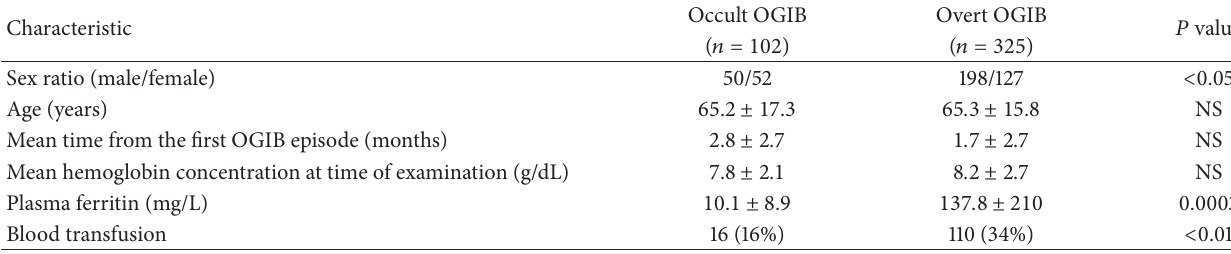
Table 1: Characteristics of patients with OGIB, per study group.